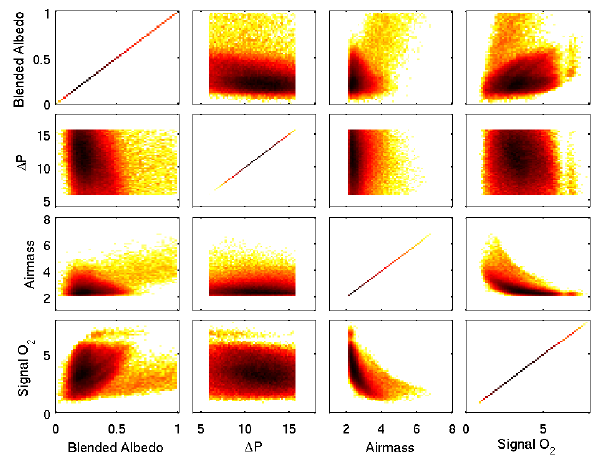
Fig. 7. A heat map of the four covariates used in Eq. (4), illustrating their orthogonality to each other. Darker colours represent denser